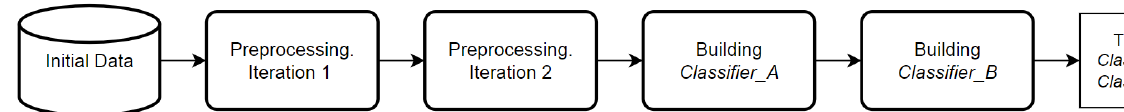
Figure 17. Confusion matrix.